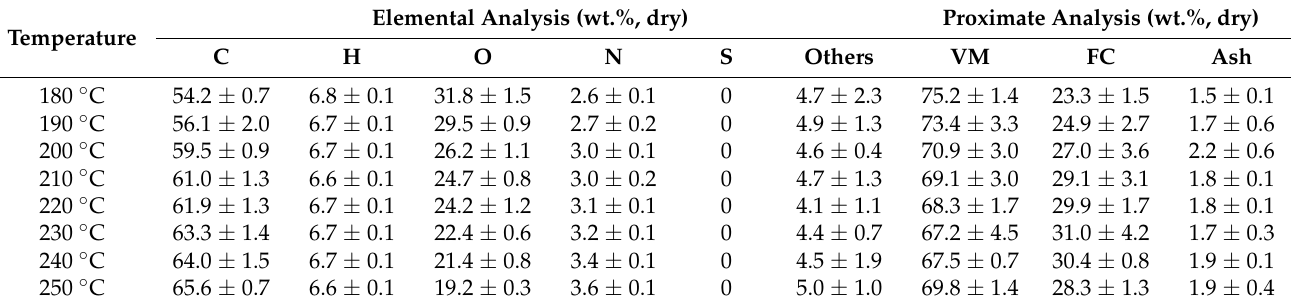
Figure 6. Oxygen and volatile organic compound (VOC) contents of SCGs produced with different reaction temperatures and water contents. Table 3. Elemental and proximate analysis of SCGs hydrothermally carbonized with different reaction temperatures (SGC: water = 1:1.5).